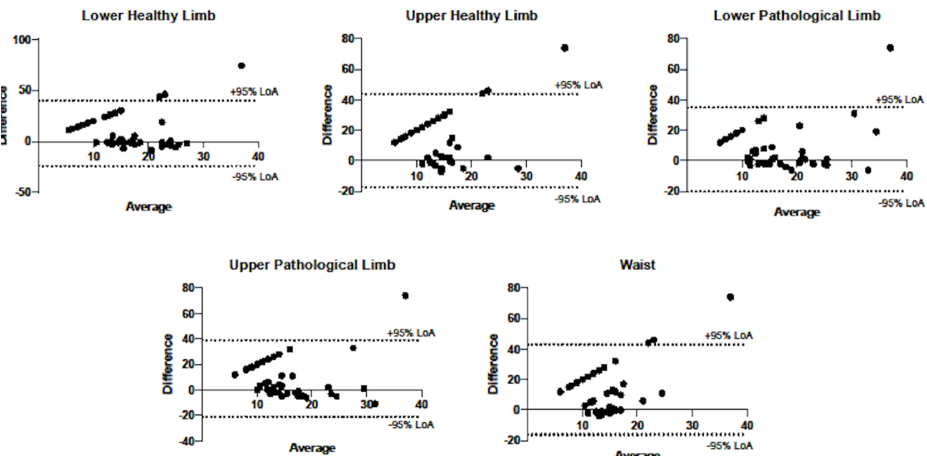
Figure 1. Bland–Altman plots for di ff erence vs. average of the two measurements methods (step counter and manual counting) during timed up and go test (TUG) for the five di ff erent step counter positionings for the pathological group ( n = 43). Dashed lines represent + 95% (upper line) and − 95% (lower line) of the limits of agreements. Legend: LoA, Limits of Agreement. Table 2. Mean absolute percentage error (MAPE) and intraclass correlation coe ffi cient (ICC) of manually counted steps and steps counted using step counters in di ff erent positions in healthy subjects ( n =